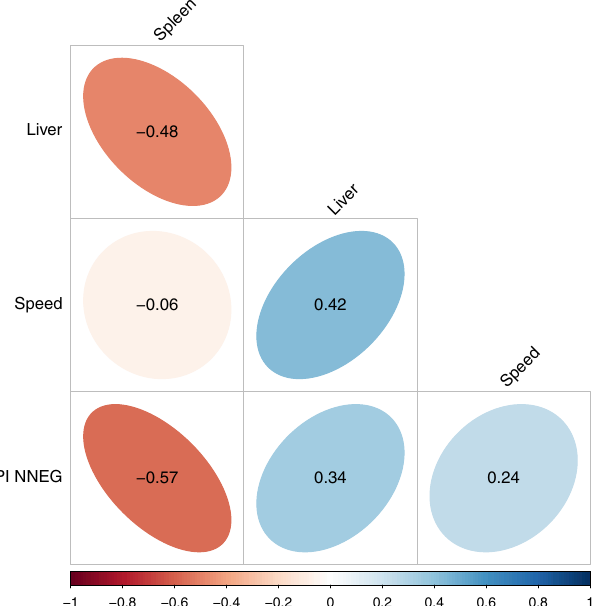
Figure 3. Relative spleen size is negatively correlated with pessimism. Visualisation of the Pearson correlations between: relative liver weight, relative spleen weight, speed (i.e. mean latency to displace cones at POS and NEG locations in the cognitive bias test) and the pessimism index for the NNEG trials (PI NNEG; see text for details). The shape and colour of the ellipses represent the direction and strength of the correlations; Pearson correlation coefficients are given in the centre of each ellipse. The critical value of r for significance (at P < 0.05) in a two- tailed Pearson correlation with 12 df is equal to ± 0.53. Thus, the only significant correlation is that between relative spleen weight and the Pessimism